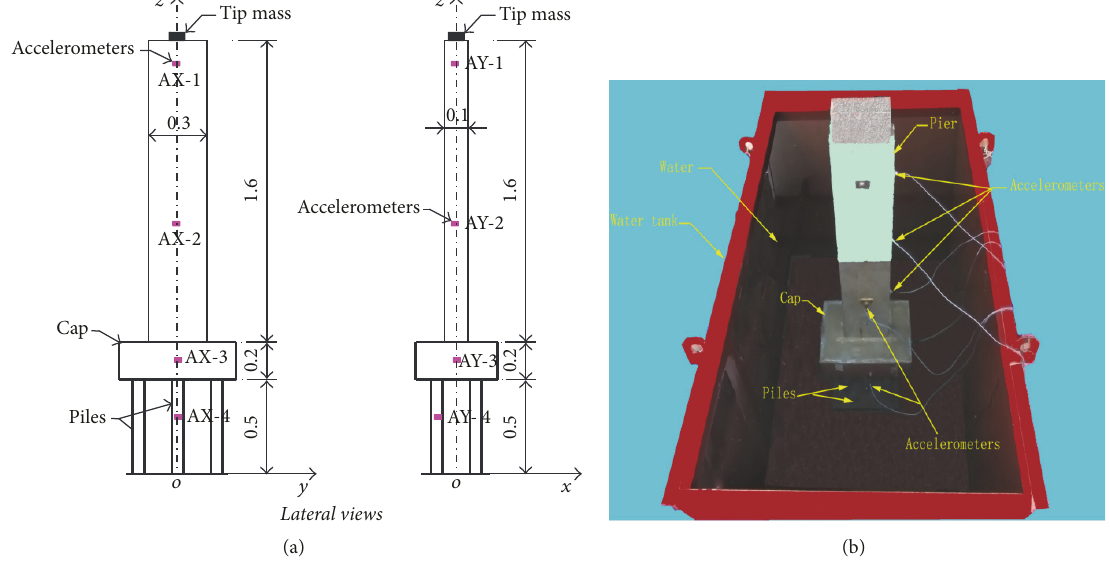
Figure 5: Measurement setup: (a) locations of the eight accelerometers mounted on the specimen; (b) picture of the testing